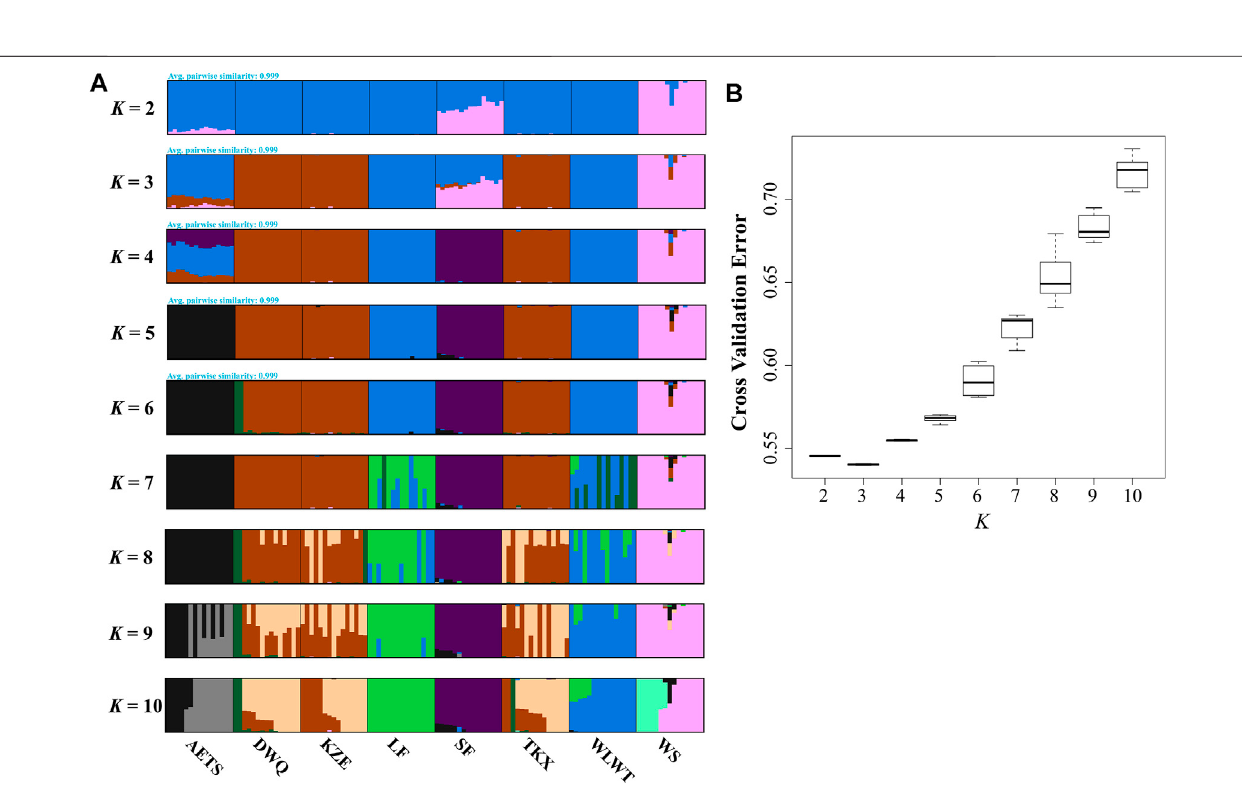
Frontiers in Genetics |